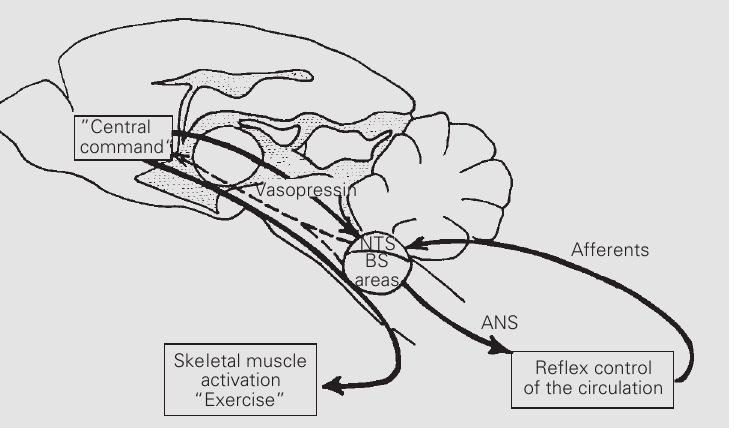
Figure 6 - Comparison of maxi- mal heart rate (HR) reduction during exercise in sedentary and trained rats pretreated with the V 1 blocker. Bars represent the differential effect of admin- istration of the antagonist (AVP ant minus vehicle re- sponse) into the NTS. *P<0.05 vs sedentary group. Repro- duced from Ref. 40, with per- mission.